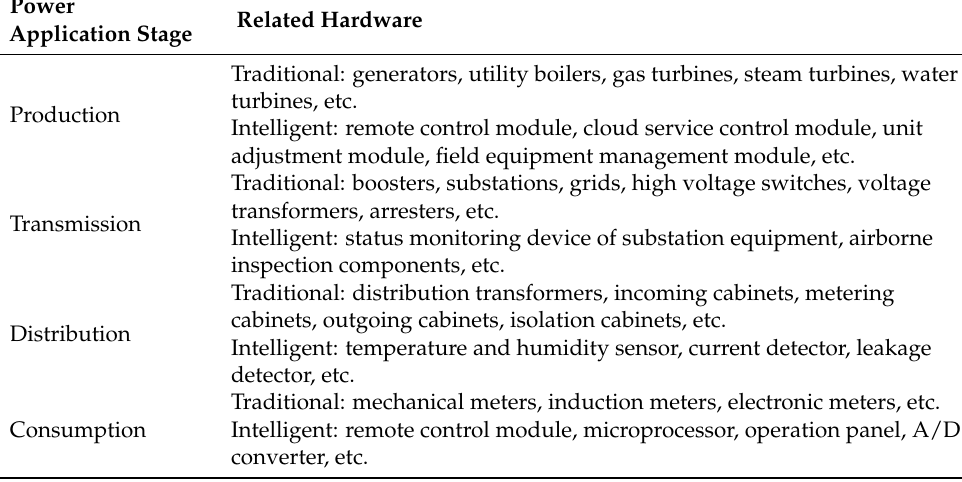
Table 1. Main hardware used to build smart